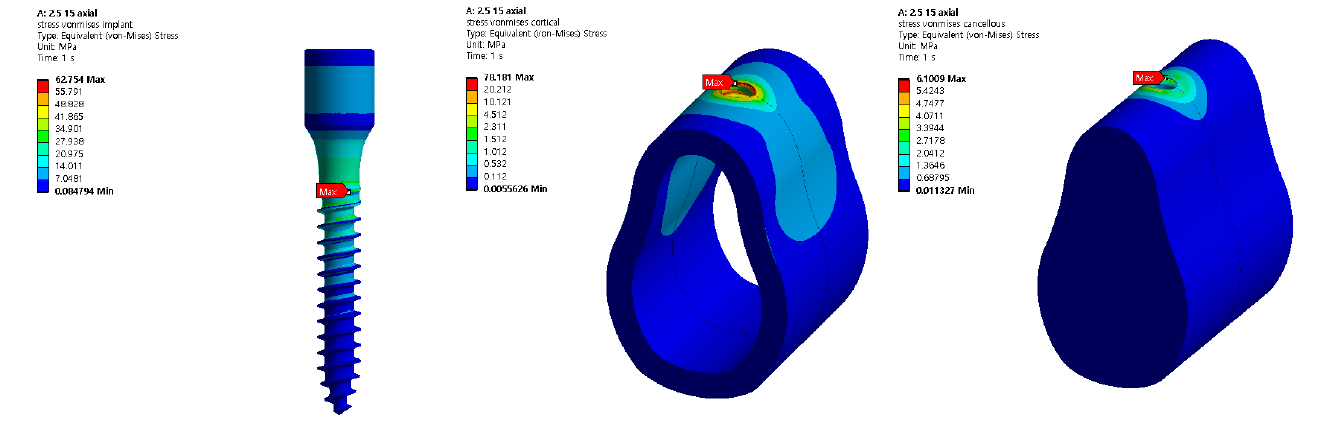
Figure 8. Von Mises stress analysis of the body with implant length 15 mm.